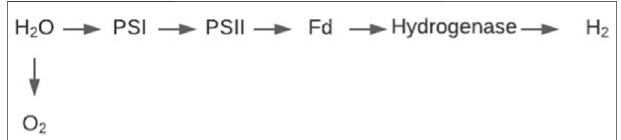
FIGURE 8 | Photosynthetic reaction scheme for bio-photolysis hydrogen